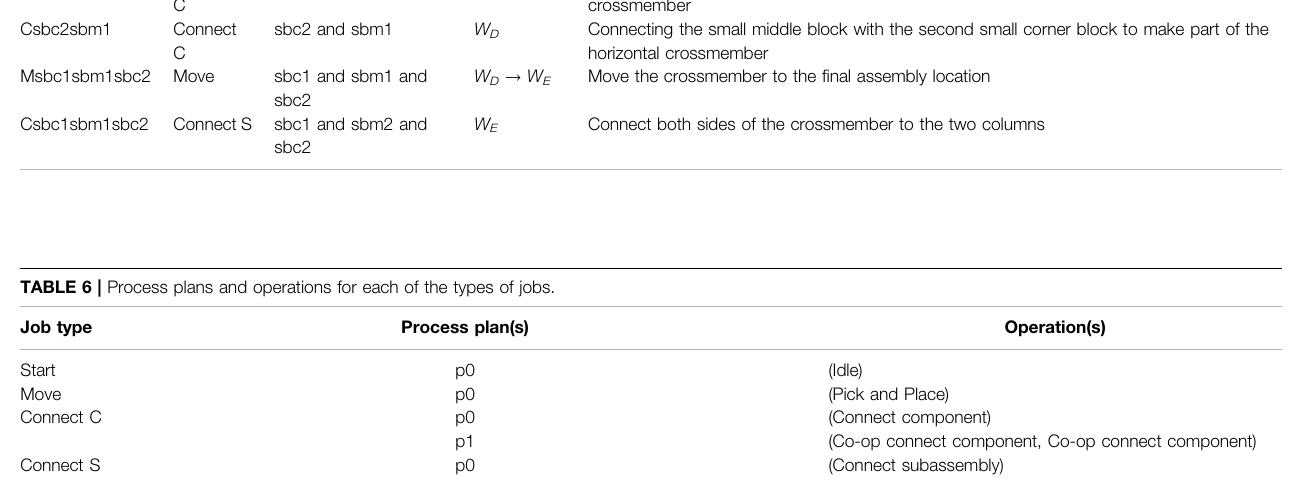
Connect both sides of the crossmember to the two columns